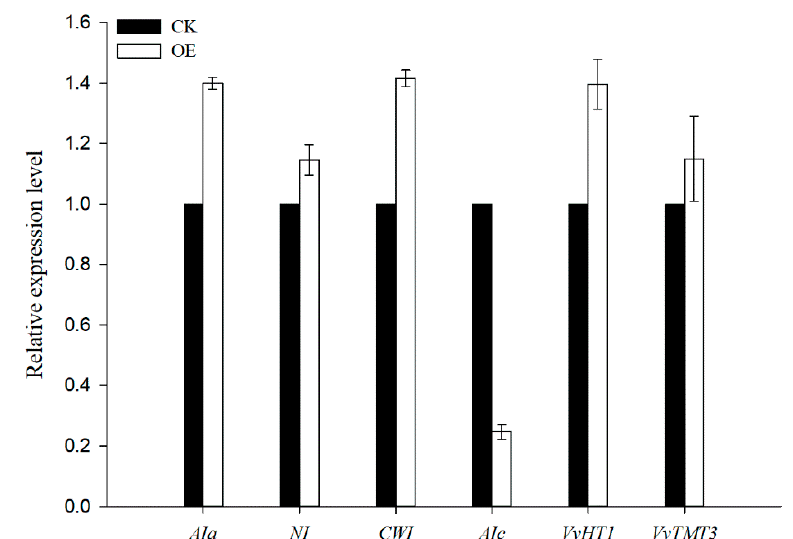
Figure 6. qRT-PCR validated the selection of sugar metabolism/transport DEGs. Results are means ± SD ( n = 3).